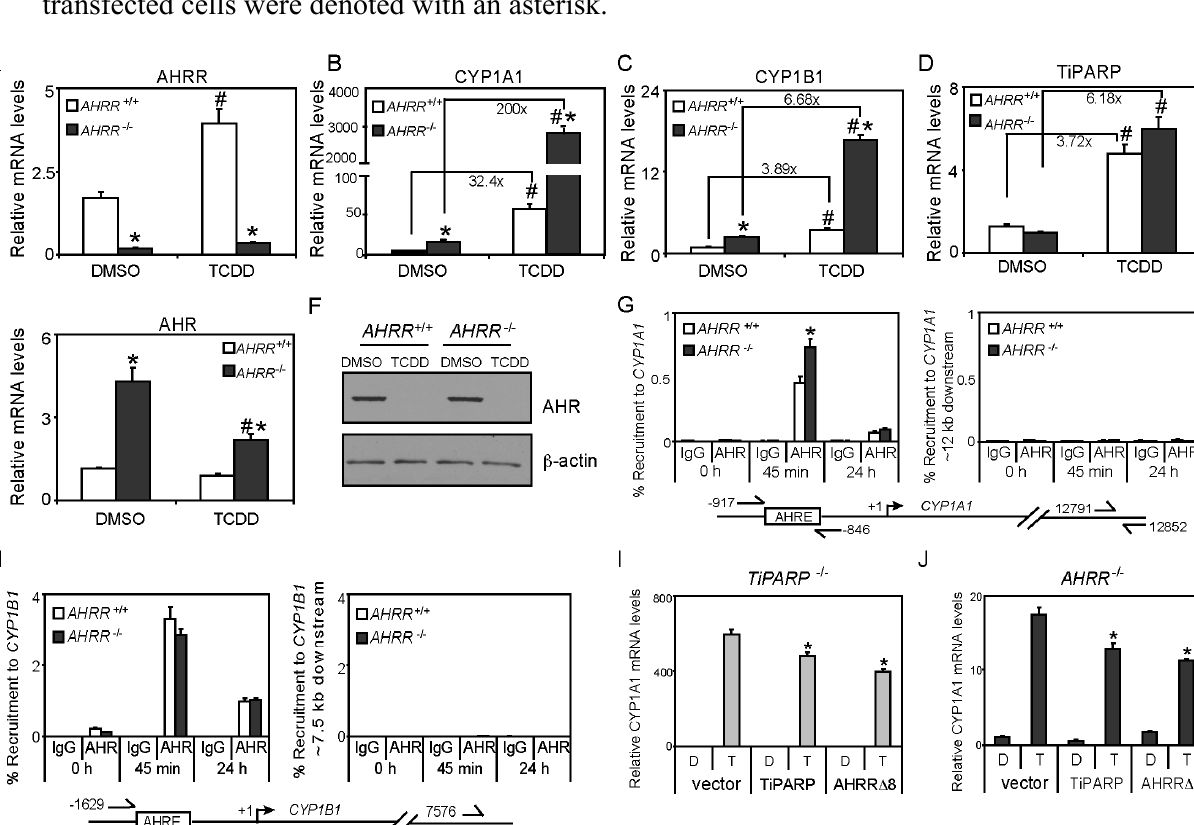
Figure 6. Immortalized AHRR − / − mouse embryonic fibroblasts (MEFs) exhibit increased AHR activity. ( A – F ) Wildtype ( AHRR +/+ ) and AHRR − / − immortalized MEFs were treated with 10 nM TCDD for 24 h. Gene expression levels were normalized to DMSO treated wildtype cells. Gene expression levels significantly ( p < 0.05) different than treatment-matched wildtype cells were denoted with an asterisk, and levels significantly ( p < 0.05) different than genotype-matched cells are denoted with a pound sign; ( H – I ) AHRR − / − MEFs have similar AHR protein levels as wildtype cells and loss of AHRR did not affect TCDD-induced AHR proteolytic degradation compared with DMSO. Data shown were representative of a Western blot from three independent experiments; ( I ) Quantification of AHR protein levels was done using ImageJ analysis software (NIH). Pound signs denoted AHR protein levels significantly ( p < 0.05) less than genotype-matched DMSO-treated cells; ( G ) AHR recruitment to CYP1A1 or to a distal downstream CYP1A1 region in wildtype or AHRR − / − MEFs; ( H ) AHR recruitment to CYP1B1 or to a distal downstream CYP1B1 region in wildtype or AHRR − / − MEFs. Recruitment levels significantly greater ( p < 0.05) than treatment-matched wildtype cells were denoted with an asterisk; ( I , J ) AHRR Δ 8 and TiPARP independently repressed TCDD-induced CYP1A1 mRNA levels. TiPARP − / − or AHRR − / − MEFs were transfected with pcDNA-AHRR Δ 8, pcDNA-mTiPARP (murine TiPARP) or empty vector (pcDNA). Cells were then treated with DMSO or TCDD for 24 h and CYP1A1 mRNA levels were determined. The data were representative of three independent experiments. Gene expression significantly less ( p < 0.05) than empty vector transfected cells were denoted with an